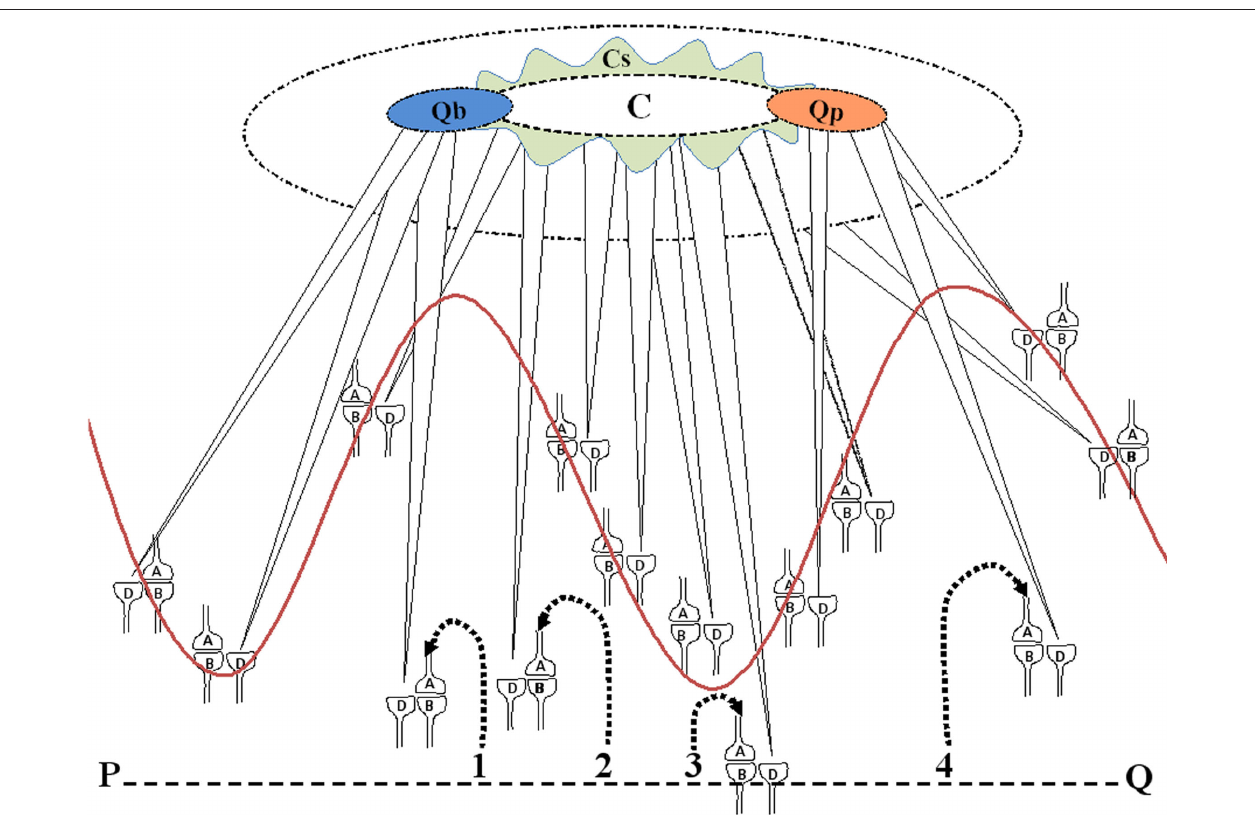
FIgure 5 | Cartoon showing the formation of primary semblance for consciousness (C-semblance) from the semblances at the LINKed postsynapses as a result of the neuronal oscillations (represented by the wave form) and background sensory inputs (representative inputs are marked as 2 and 3 from the line PQ which represents the environment). Note the elliptical-shaped net functional semblance C representing consciousness. Around the elliptical-shaped C-semblance, is a wave-shaped extension that represents the subjective variations of C-semblance among the members of a species. Note the center-surround configuration of the C-semblance. The center denotes the species-specific features and the surround